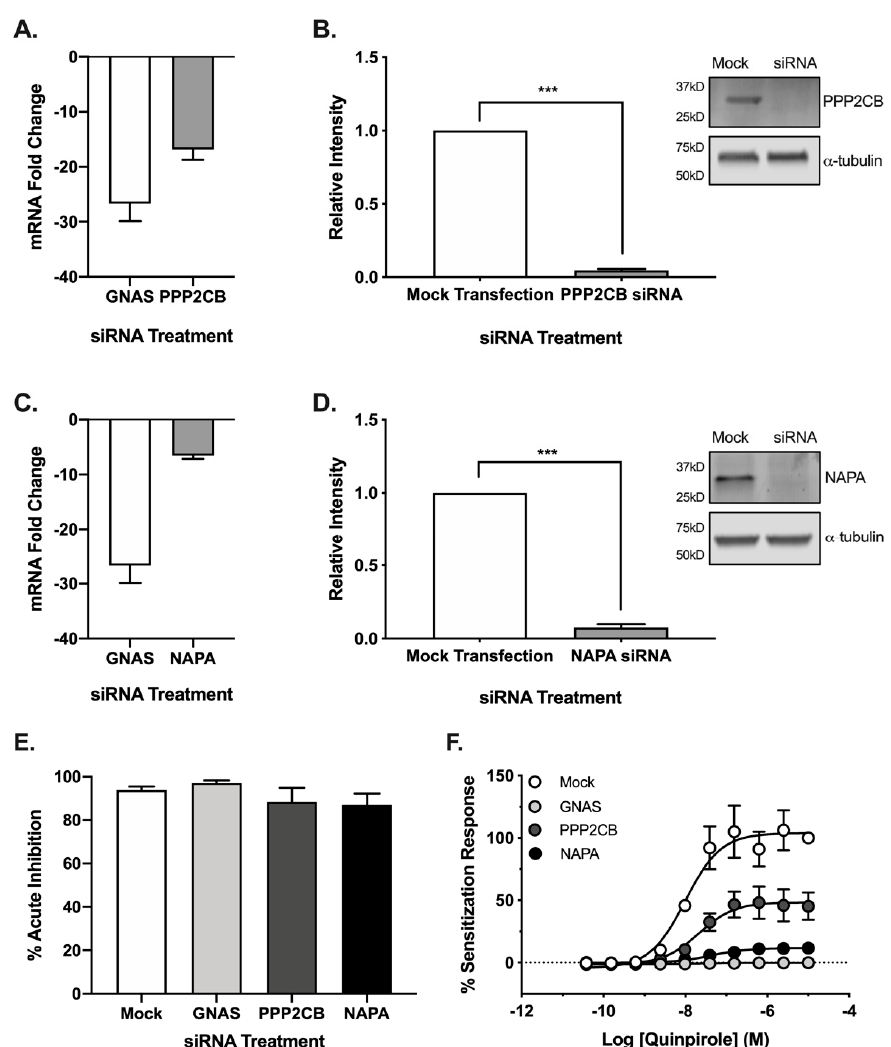
Figure 3. Gene knockdown does not alter acute D 2 signaling but decreases the maximum efficacy of AC sensitization response in HEK-AC5/D 2L cells. Biochemical validation of siRNA knockdown was carried out by qPCR ( A , C ) and western blotting ( B , D ). Cell fractions from mock or siRNA-treated cells were subjected to western blot analysis using target antibodies for ( B ) PPP2CB and ( D ) NAPA, as well as listed loading controls. Data were standardized to mock transfection (left) and representative immunoblots (right). Statistical analysis was performed (t-test), *** p < 0.001. The ability of the G α i/o -coupled D 2 receptor to inhibit AC remained intact following gene knockdown ( E ). Quinpirole (3 μ M) maximally inhibited the AC response to acute stimulation with 3 μ M forskolin under all siRNA conditions. siRNA knockdown of target genes reduced the maximal efficacy of the AC sensitization response without affecting the potency of quinpirole ( F ). Experiments (n = 3) were performed in duplicate with SEM shown.